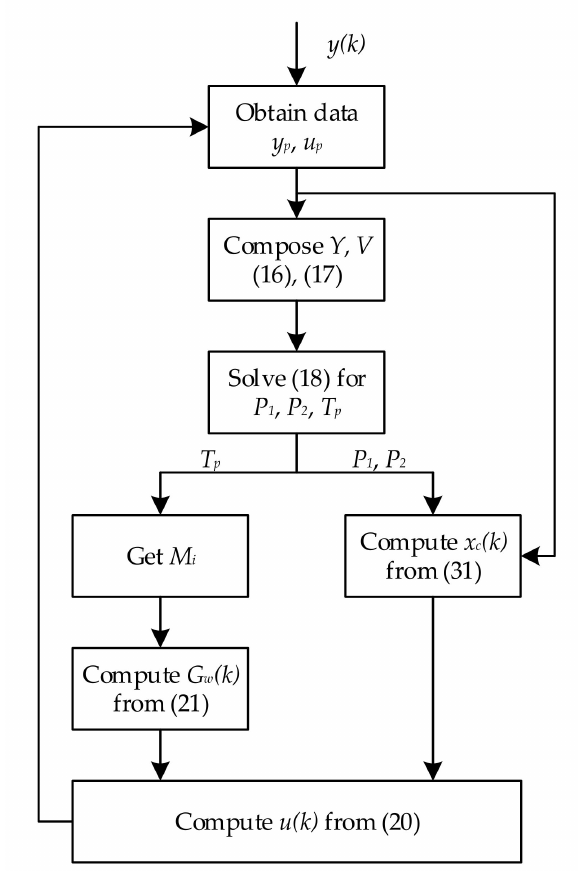
Figure 5. The flowchart of the proposed data-driven inertia control